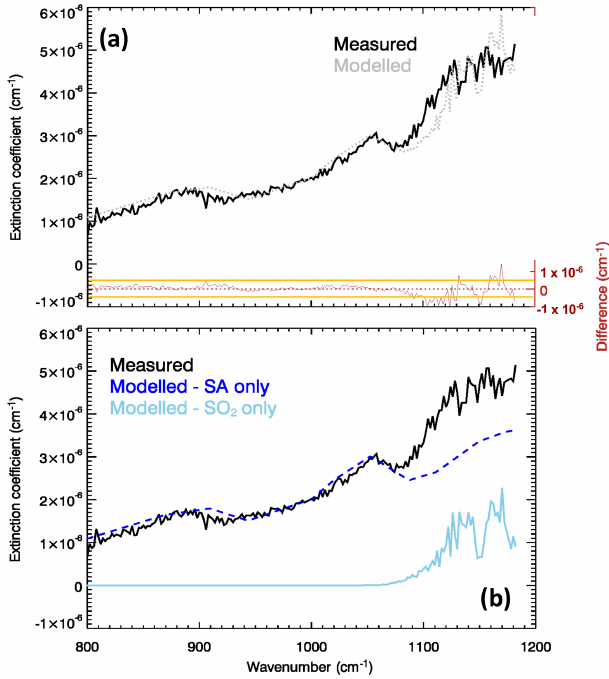
Figure 1. (a) Measured (solid black line) and modelled/fitted (dot- ted grey line) extinction coefficient of the Masaya volcano plume for the observation of 15 March 1998 at 17:06UTC. Residuals (modelled minus measured extinction coefficient) are also shown in red. Orange lines show the corresponding standard deviation √ ± 1 σ = 2 σ ext interval (here, excluding specific sys- residuals k plume , meas tematic spectroscopic errors transmitted from the SA laboratory has been considered conservatively equal measurements, σ k ext plume , mod to σ k ext ; details on the calculation of σ k ext are given in plume , meas plume , meas Appendix A). (b) Individual components of the modelled extinction coefficient due to SA (blue line) and SO 2 (sky blue